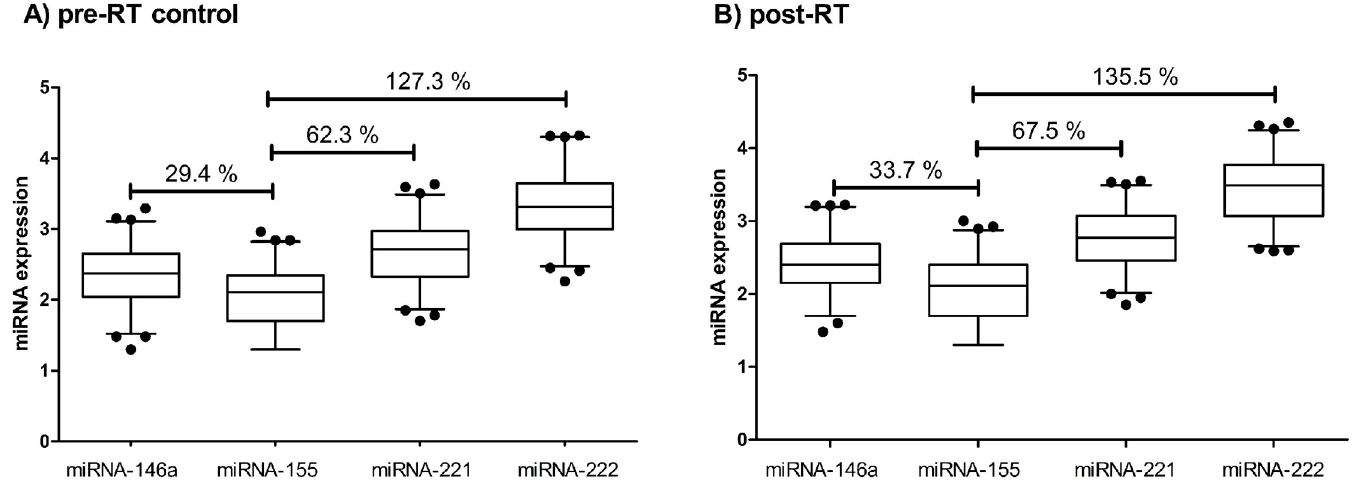
Fig 1. Expression of miRNA-146a, -155, -221 and -222 in blood of BC patients at pre-RT control (A) and post-RT (B) treatment. miRNA expression was calculated as log(2 -DCt )+3. Results are expressed as percentile 2.5–97.5. Percentage of expression increase in comparison to miRNA-155 is indicated (%).